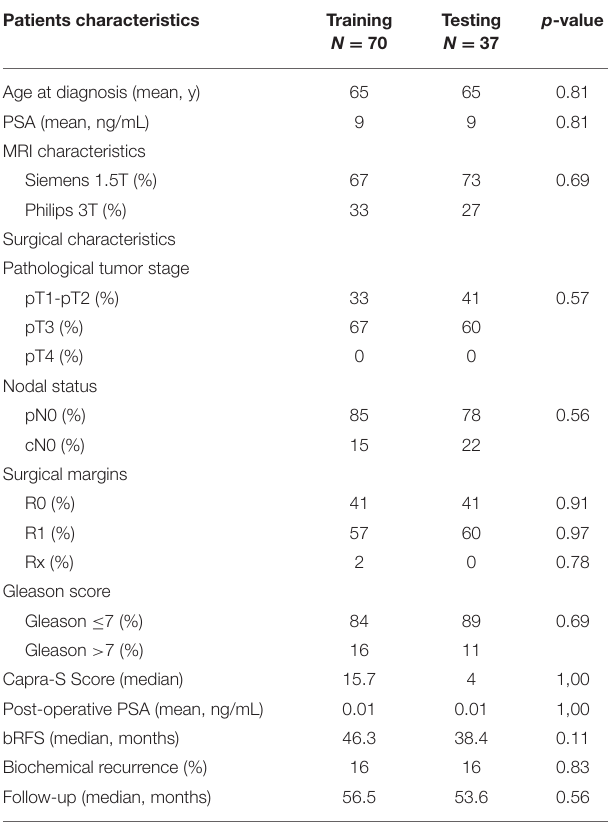
TABLE 2 | Patients and tumors characteristics in training and testing